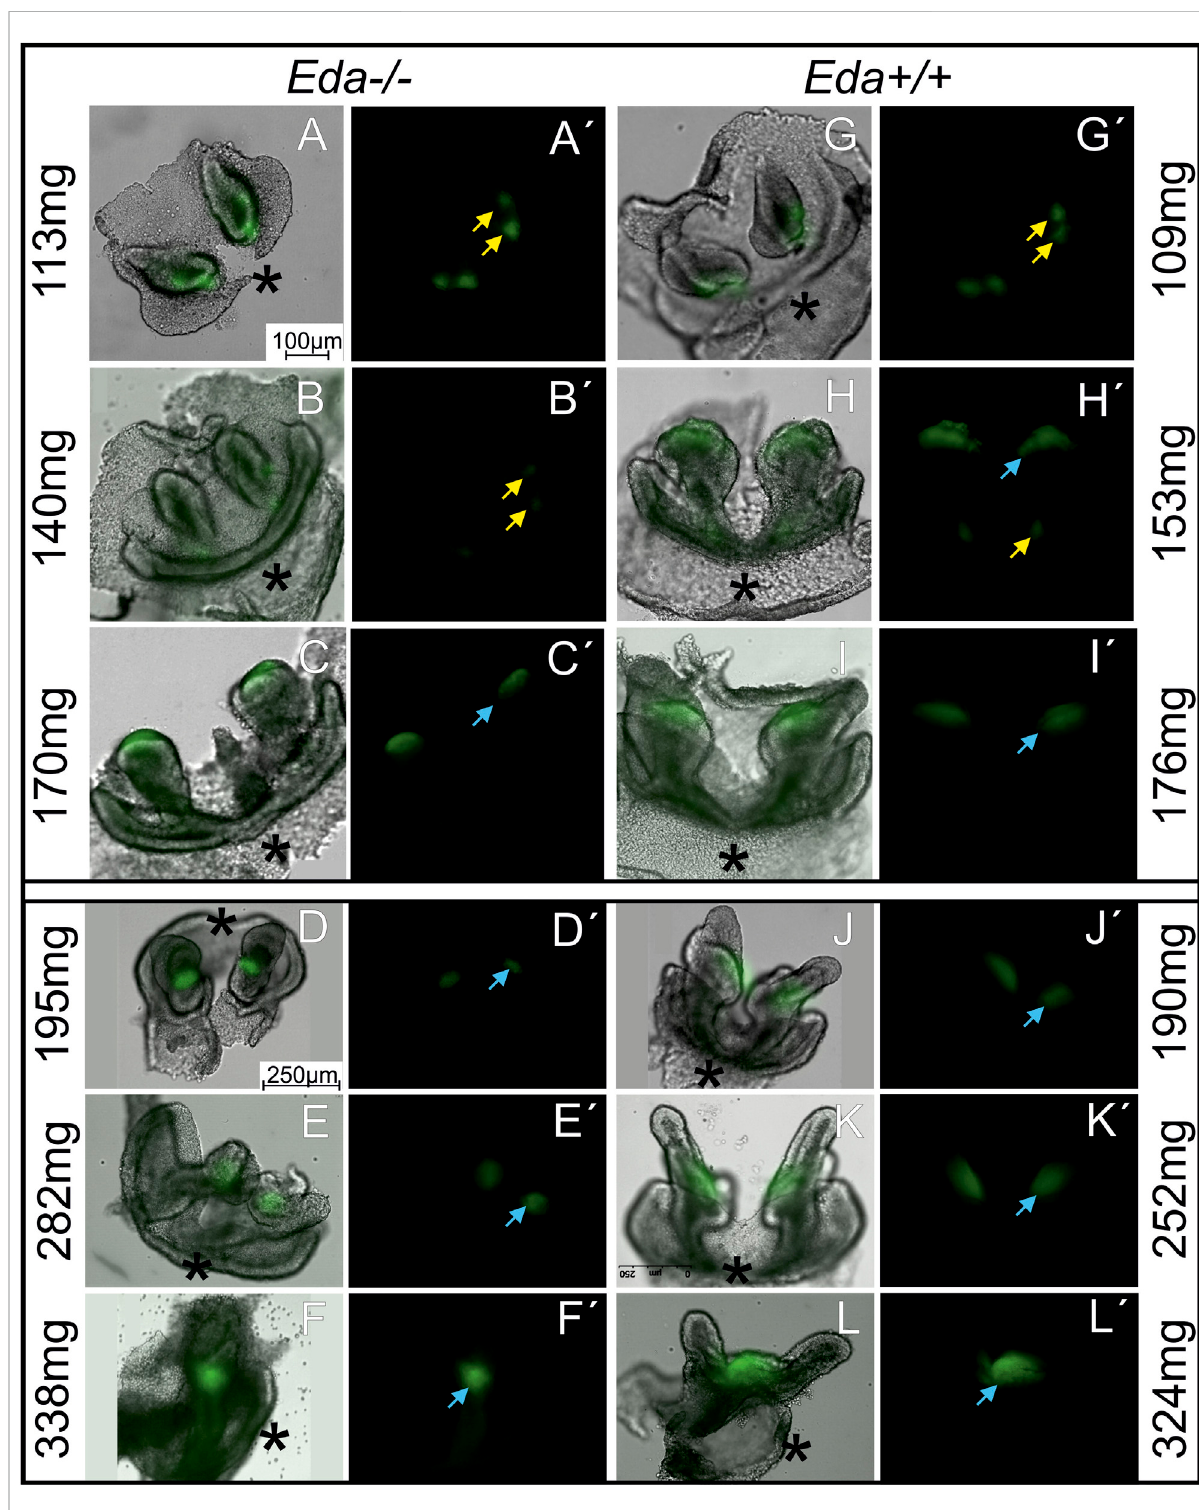
The morphology and Shh expression in the developing lower incisor area in Eda − / − (A – F 9 ) and Eda+/+ (G – L 9 ) embryonic mandibles. Shh expression regions of rudimentary (yellow arrow) and functional (blue arrow) incisor primordiums (see also schematics in Figure 2) are visualised using green fl uorescence on the dissociated dental and adjacent epithelia of the incisor area in the Eda − / − embryos (A – F) and using green fl uorescence in the dark fi eld image (A 9 – F 9 ) at ED 14.3 (A,A 9 ,B,B 9 ) , at ED 14.7 (C,C 9 ) , at ED15.5 (D,D 9 ,E,E 9 ) and at ED15.7 (F,F 9 ) and of